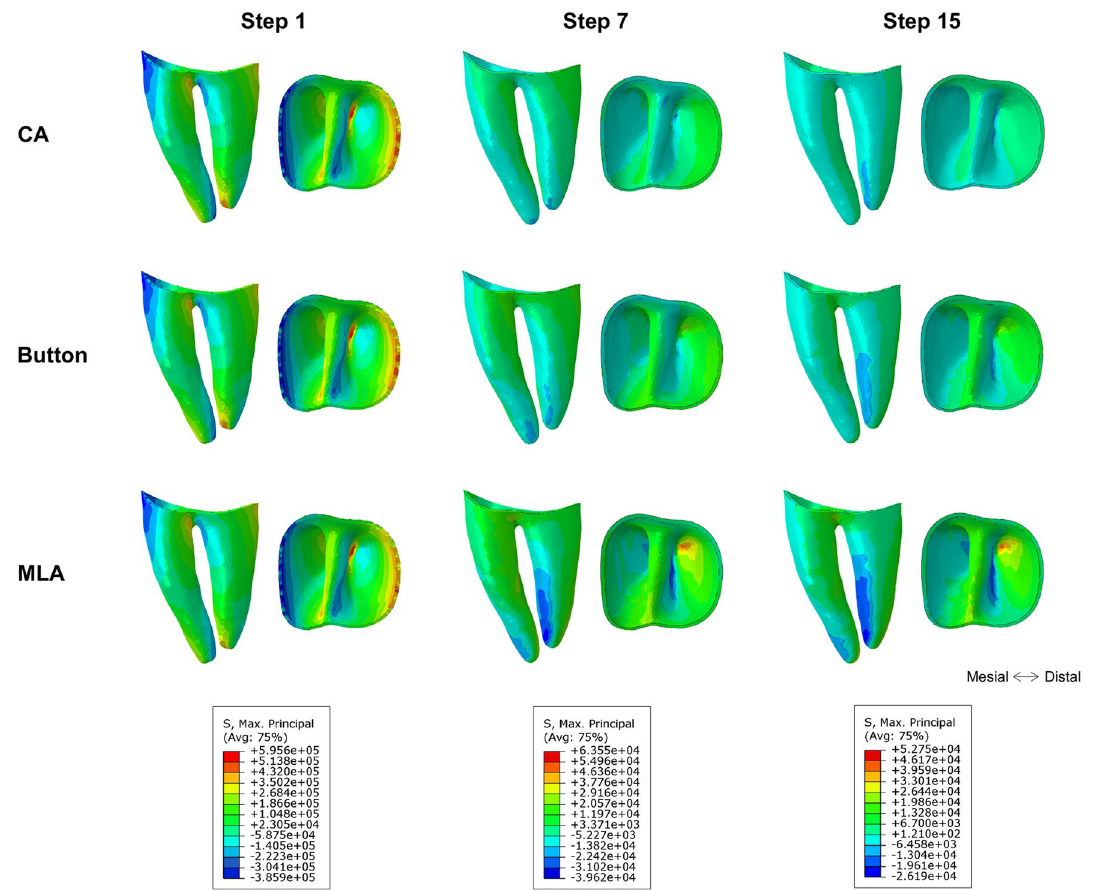
Fig. 4 Max principal stress distribution of PDL at the beginning, intermediate, and final